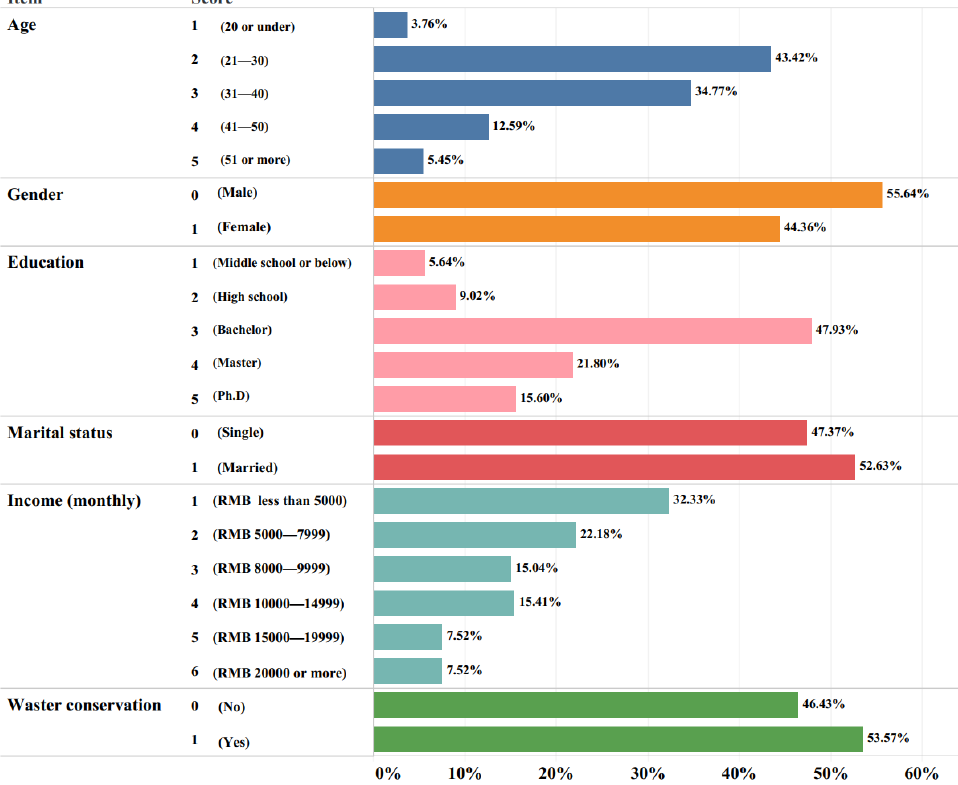
Figure 1. Distribution of the sample (N = 532).